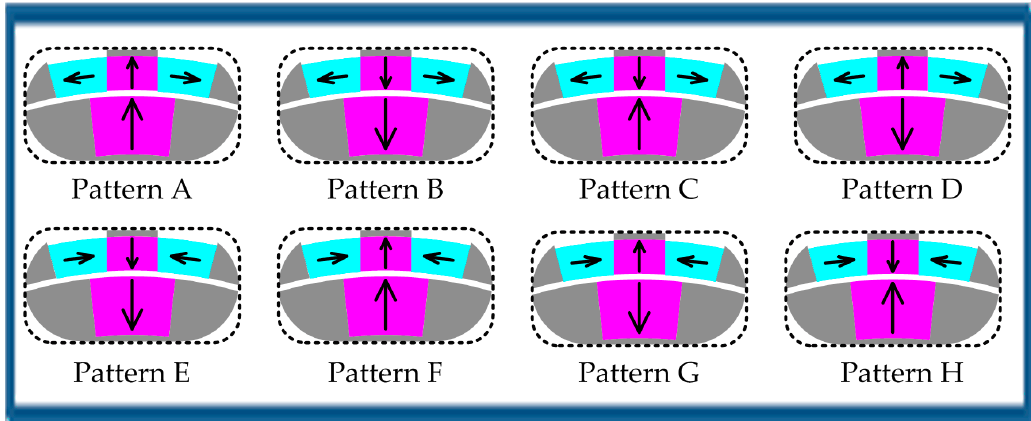
Figure 5. Different magnetization patterns.